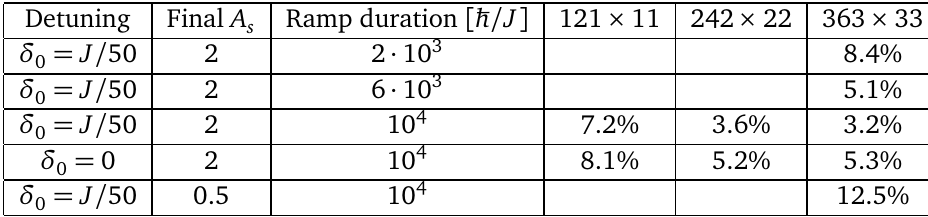
Table 1: The percentage loss of the population due to the transfer to undesired states for different system sizes, detunings, and ramp